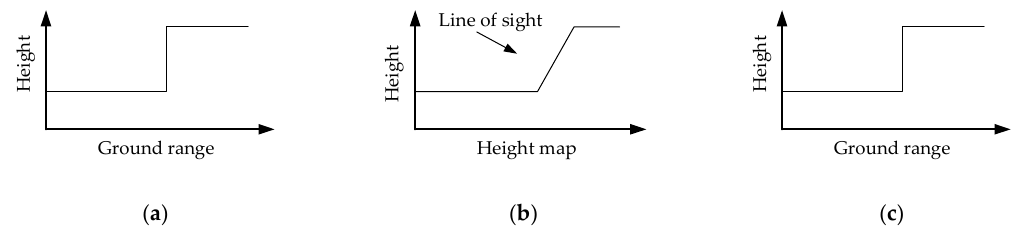
Figure 4. Surface changing chain. ( a ) Initial TomoSAR surface of a building in the ground range domain, which serves as our input. ( b ) Projected surface in the height map. ( c ) The final output surface of our method in the ground range domain.